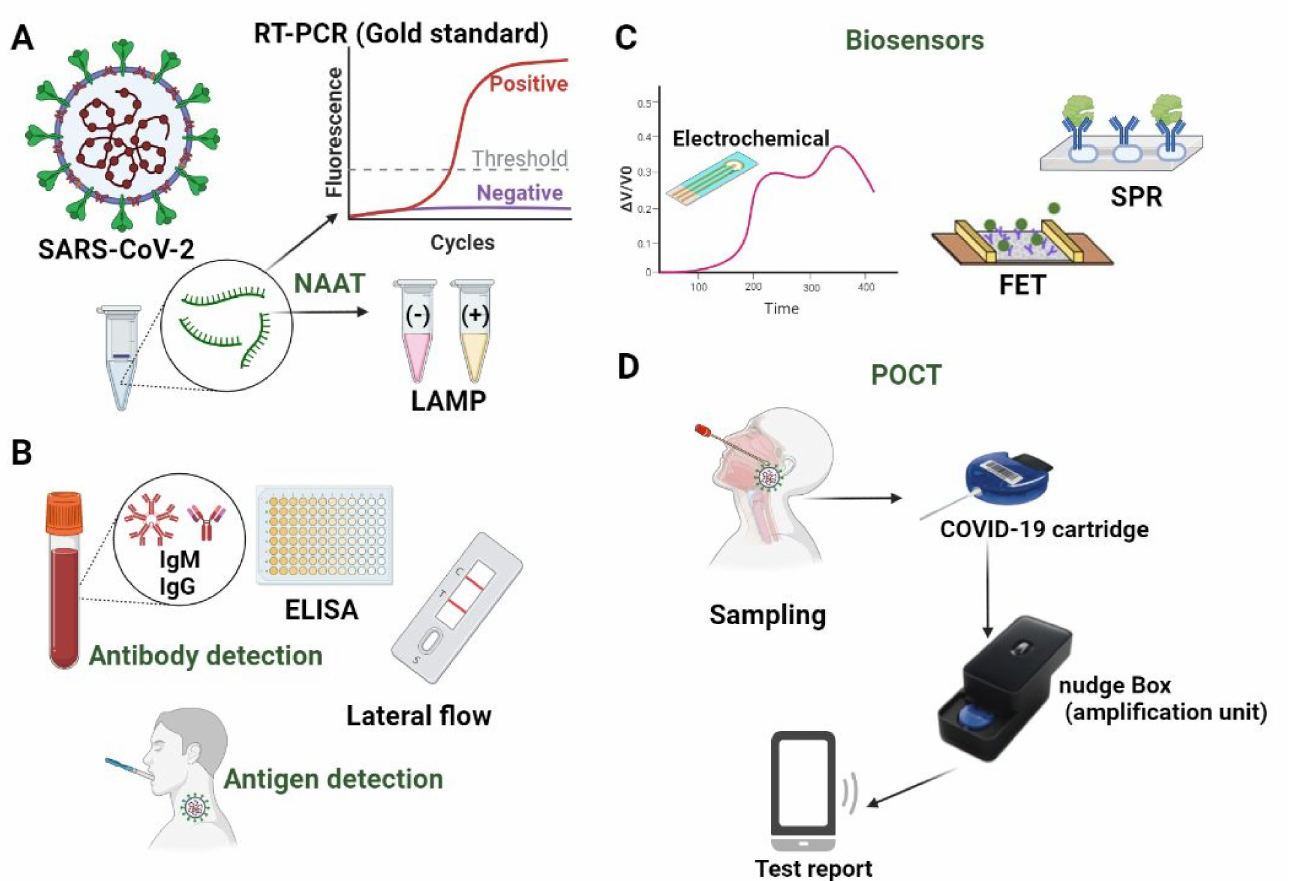
Figure 1. Examples of detection systems for SARS-CoV-2: ( A ) Nucleic Acids Amplification Testing-reverse transcription- polymerase chain reaction (NAAT-RT-PCR, gold standard for diagnostic), colorimetric real-time Loop-Mediated Isothermal Amplification (RT-LAMP) reaction; ( B ) detection of viral antigens and IgG/IgM antibodies using lateral flow tests/ELISA (enzyme-linked immunoassays); ( C ) schematic representation of a biosensor for SARS-CoV-2 detection; ( D ) schematic workflow of CovidNudge Point of Care diagnostic for SARS-CoV-2 (adapted from Gibani et al.